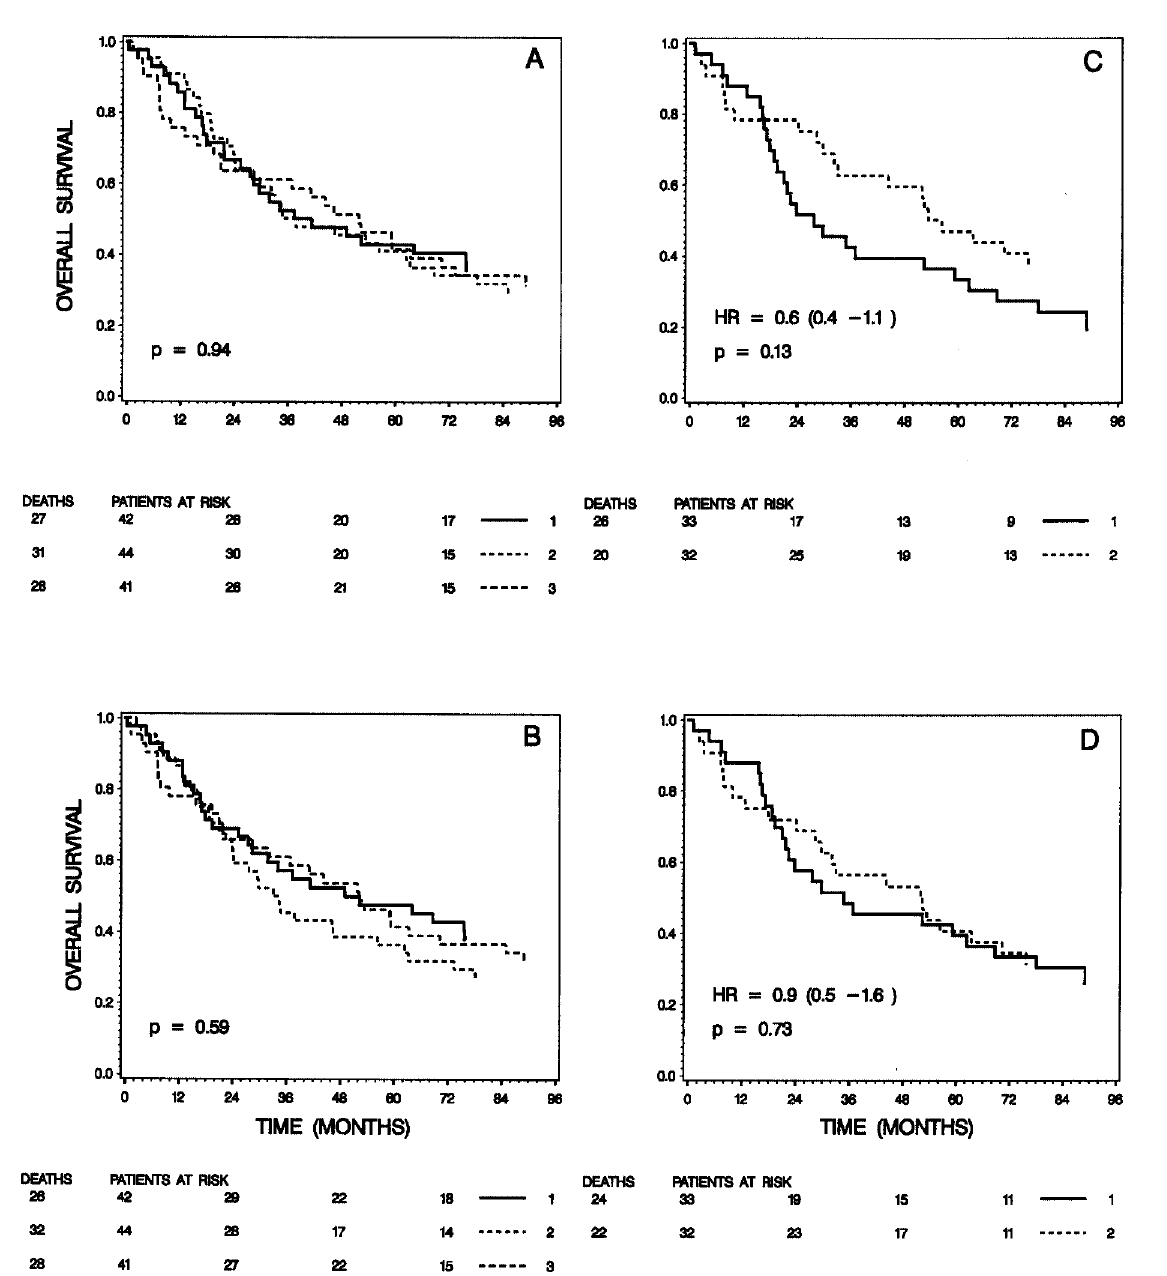
Fig. 4. Kaplan–Meier survival plots for 127 patients, under each curve the number of events (deaths) are shown to the left and the number of patients at risk at 0, 24, 48 and 72 months are shown below the curve for each stratum. (A) Total unadjusted SPF categorized by tertiles (1: < 21%, 2: 21–27%, 3: > 27%). (B) Total adjusted SPF categorized by tertiles (1: < 12%, 2: 12–20%, 3: > 20%). (C) Unadjusted SPF of subpopulations with DI > 1 . 4 dichotomized by the median SPF (1: (cid:2) 34%, 2: > 34%). (D) Adjusted SPF of subpopulations with DI > 1 . 4 dichotomized by the median SPF (1: (cid:2) 25%, 2: > 25%). For (C) and (D), the hazard ratio (HR) with its 95% confidence interval is